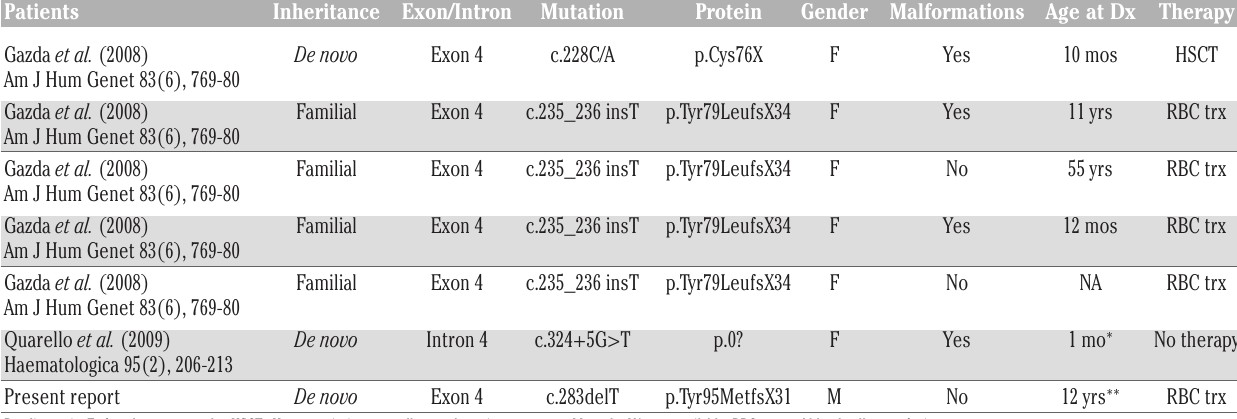
Table 2. Diamond-Blackfan anemia patients with mutation in exon 4 or intron 4.